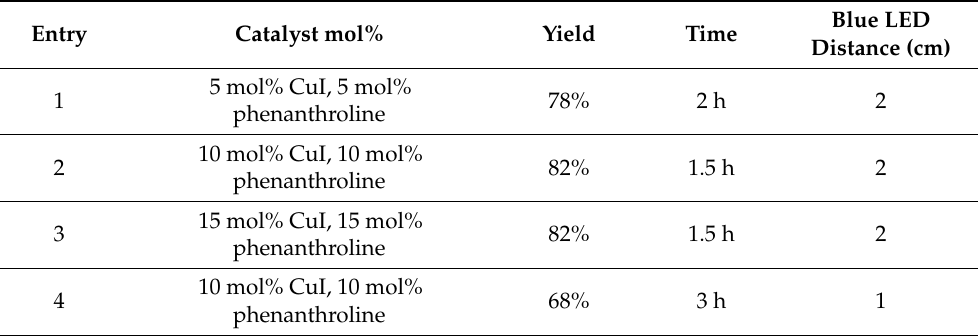
Table 2. Optimization of reaction conditions for the synthesis of 3a utilizing CuI and phenanthro- line